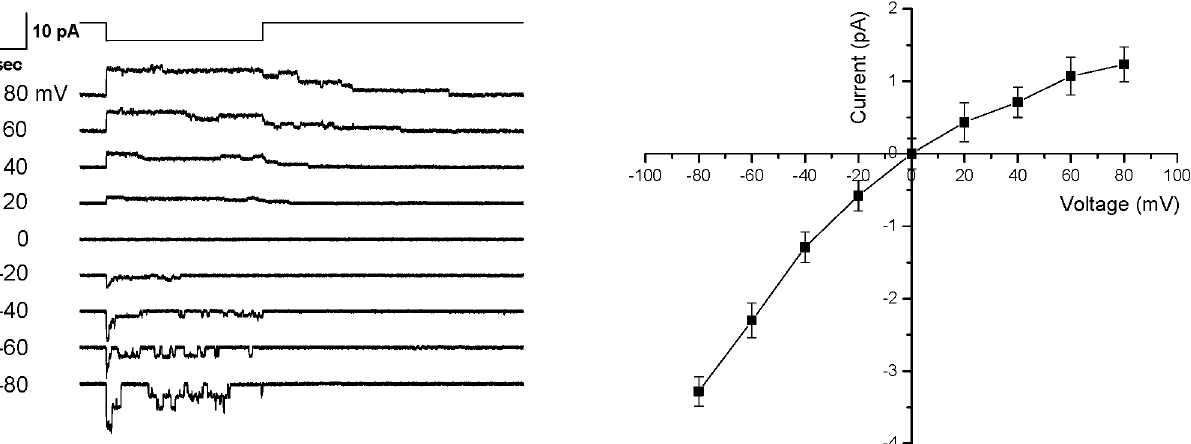
Fig 3. Voltage-dependent inactivation of the hPIEZO1 split protein. Single channel recording of the split protein was measured between 80 to -80 mV membrane potential ( left panel ). For negative membrane potentials we observed rapid inactivation. The mechanical stimulus was suction at -30 mmHg as shown above the current traces. A plot of single channel currents as a function of voltage ( right panel ) showed a reversal potential at ~ 0 mV. (n = 4, error bars are the S.D.).